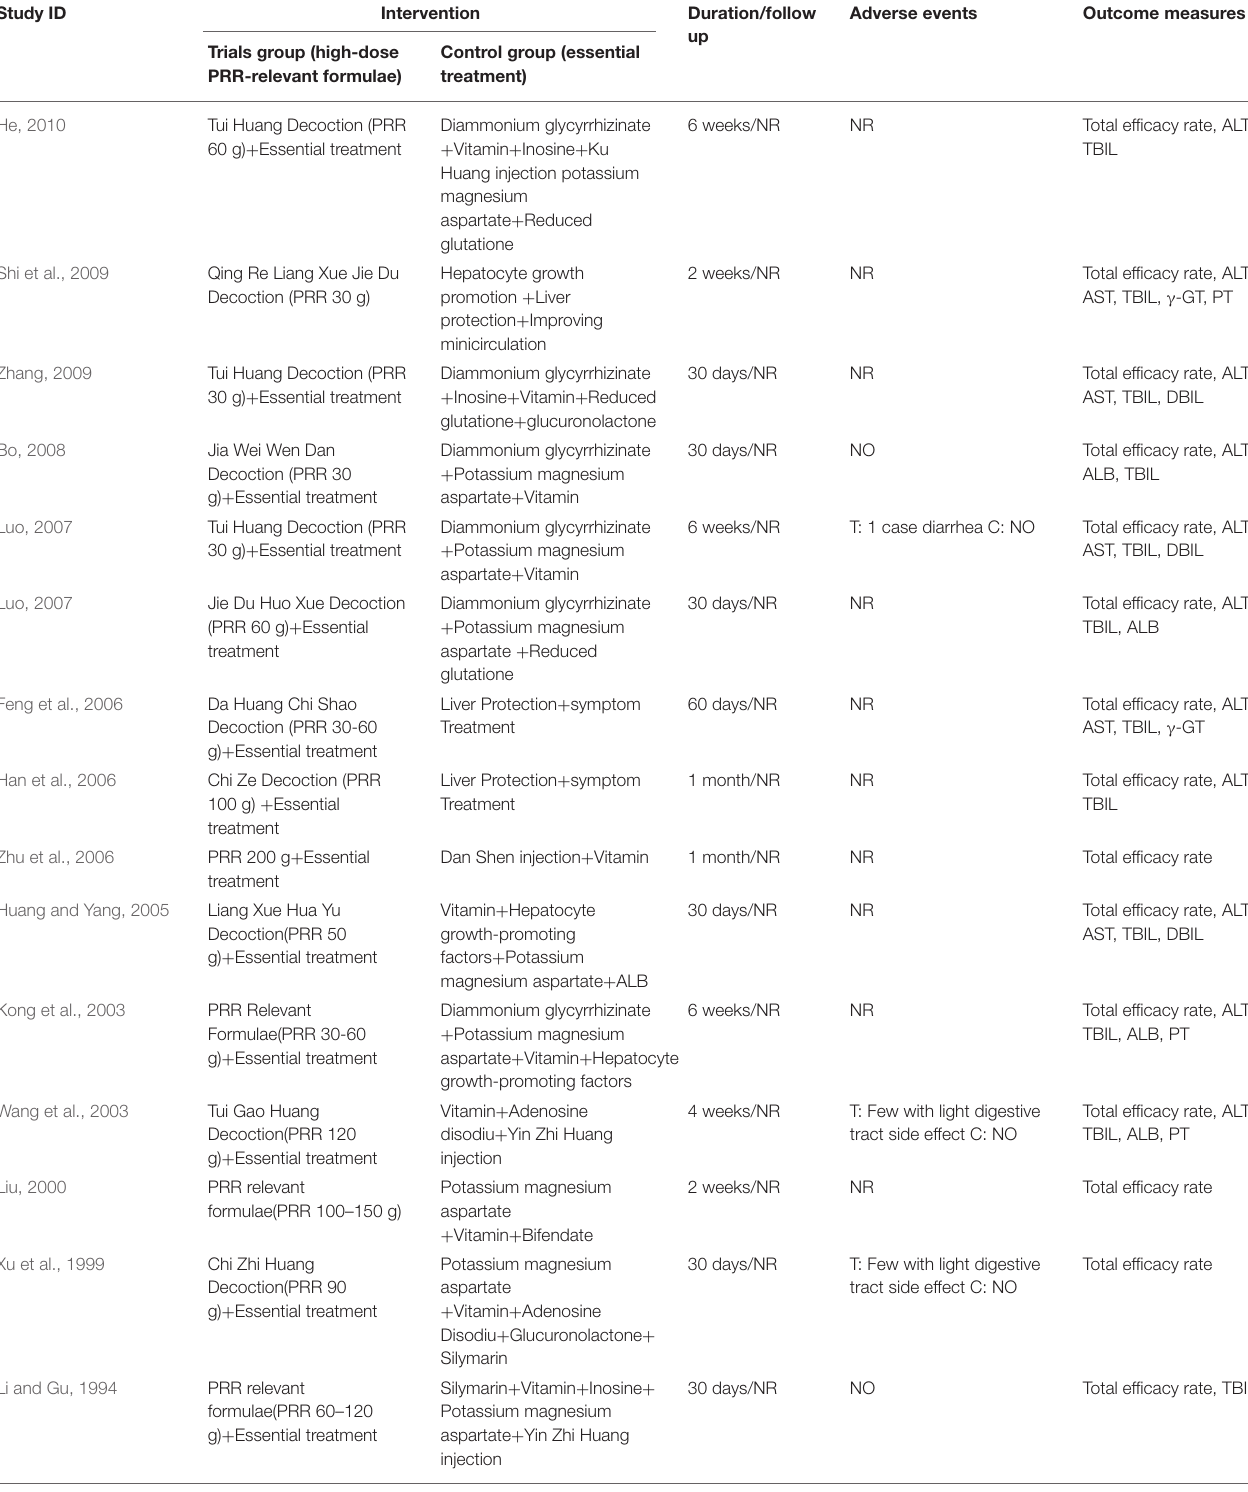
TABLE 2 | Intervention and outcome measures of included studies. Study